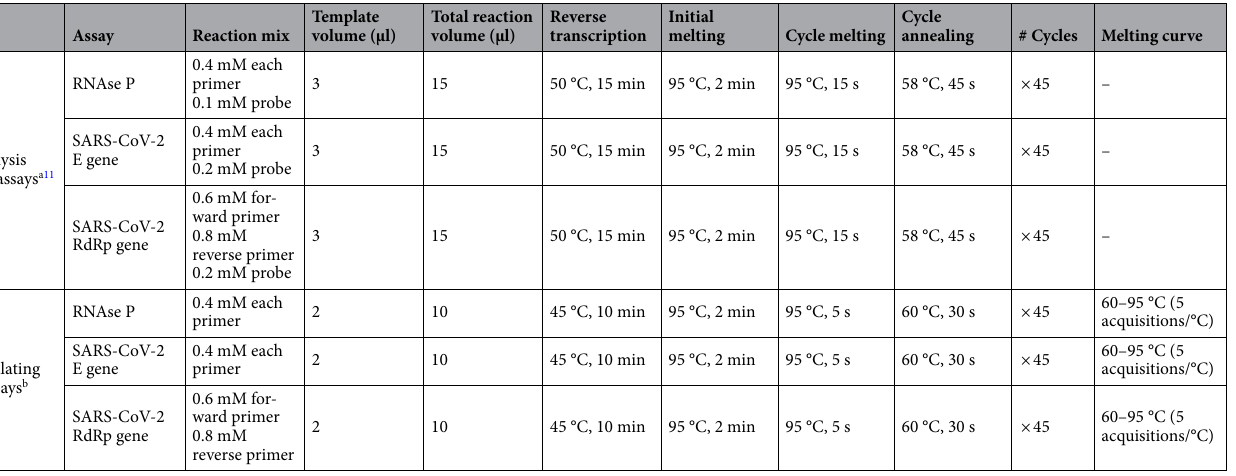
Table 2. Nucleic acid amplification assays conditions. a SuperScript™ III Platinum™ One-Step qRT-PCR Kit (ThermoFisher). b SensiFAST One-Step SYBR Green No-Rox Master Mix (Bioline GmbH, Luckenwalde,